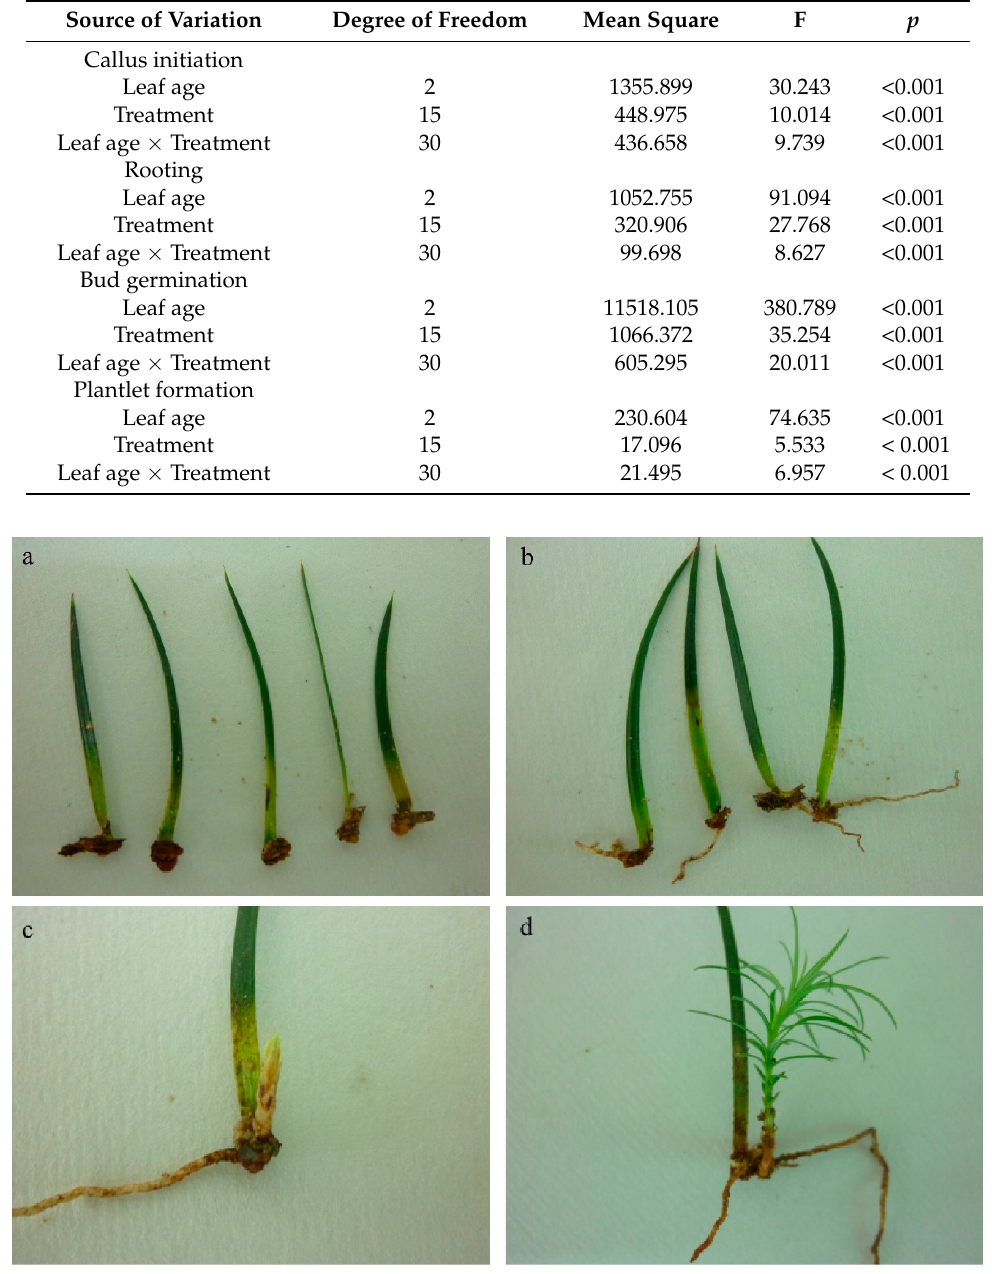
Figure 2. Growth of Chinese fir cuttings. ( a ) Callus initiation; ( b ) root formation; ( c ) bud germination; and ( d ) plantlet formation.